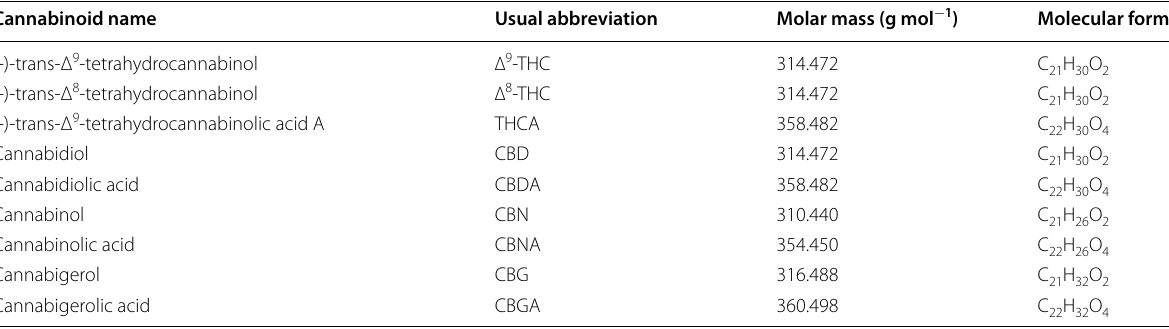
Table 1 Common cannabinoids and their molecular